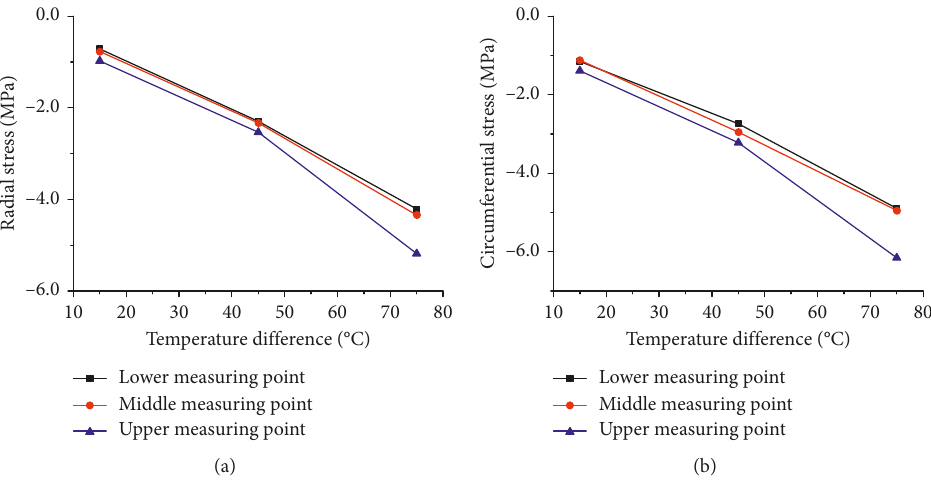
Figure 10: Maximum of thermal stress under different heating temperatures (0 ° C). (a) Radial stress. (b) Circumferential